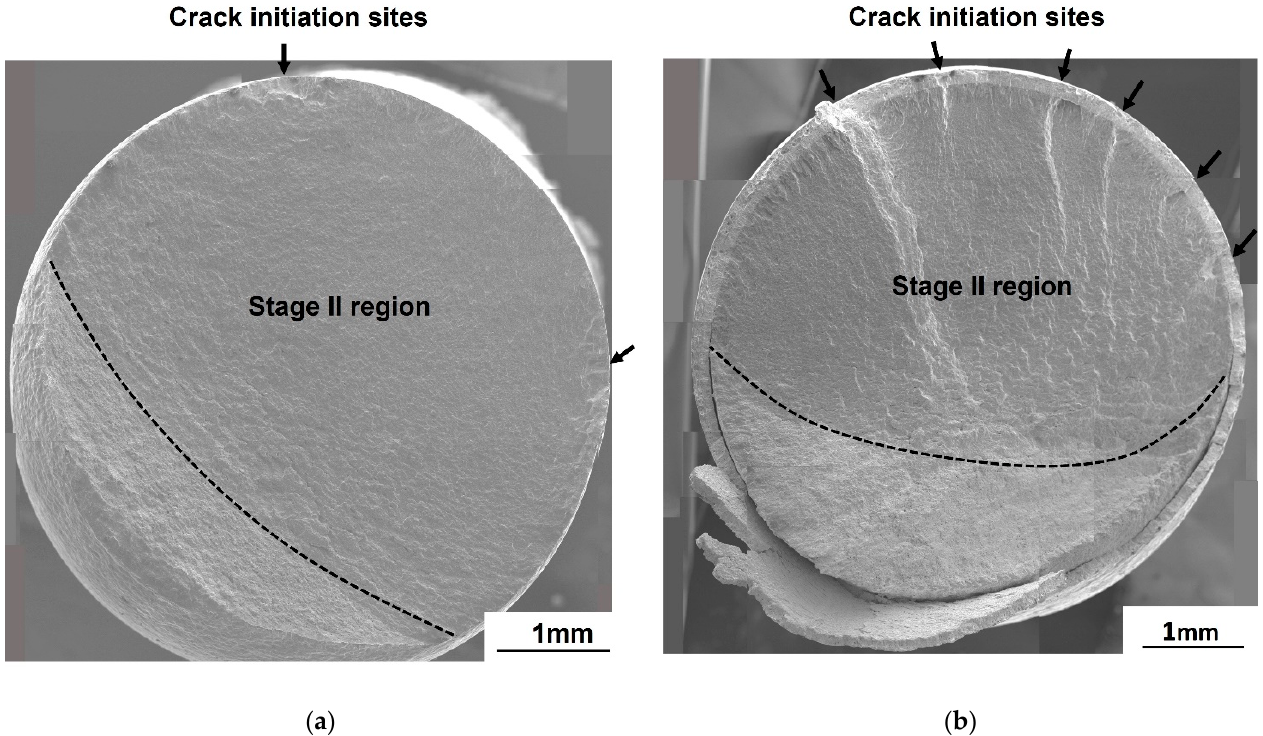
Figure 10. Fatigue fracture surfaces of normalized AISI 1020 steel in the low cycle fatigue at R = − 1.0: ( a ) non-galvanized, σ max = 224.8 MPa and ( b ) galvanized, σ max = 196.3 MPa.